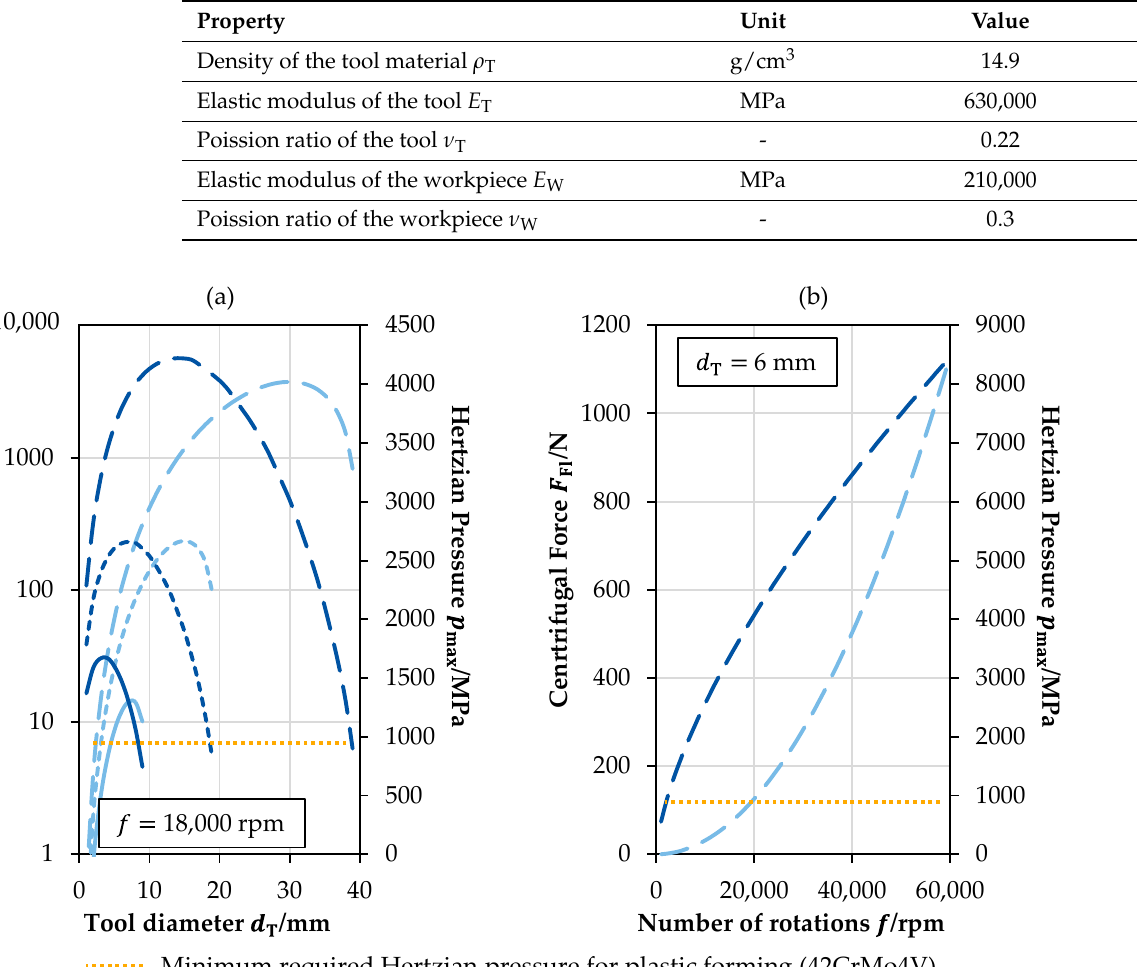
Figure 2. Centrifugal force and Hertzian pressure for the contact between ball and cylinder, as shown in Figure 1, for dependence of the tool (ball) diameter ( a ) and the number of rotations ( b ). As mentioned, the forces and pressures calculated do not take into account the losses occurring during the real process. To ensure that the losses do not reduce the process forces and pressures below the necessary level, in the following, the experiments using a tool prototype are described in detail.